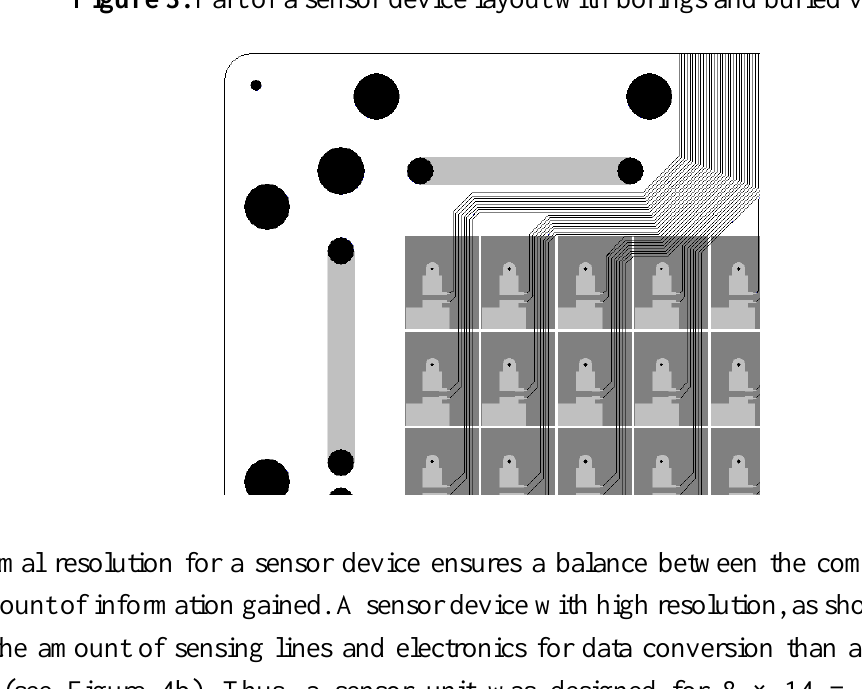
Figure 4. Different resolutions for serpentine flow channels.